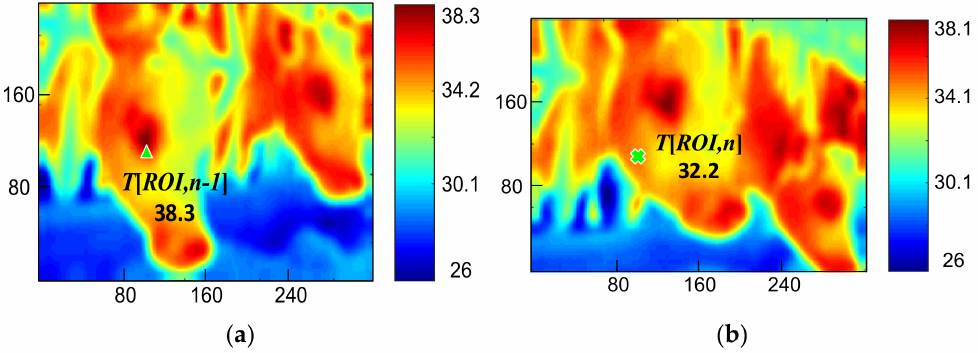
Figure 9. Excessive head movement removal. ( a ) time n − 1 frame. ( b ) time n